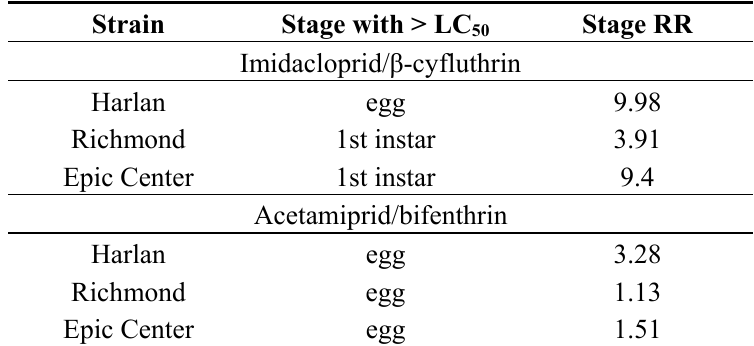
LC 50 values followed by different letters are significantly different determined by the failure of the confidence intervals to overlap (PoloPlus 2004).